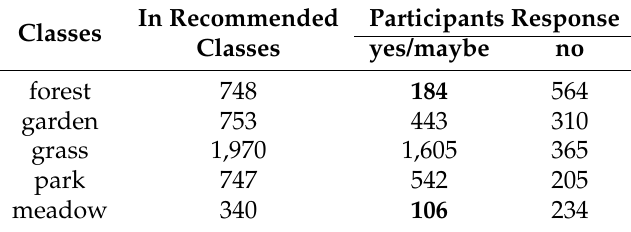
Table 3. Classes with respect to recommendations and participant responses after the